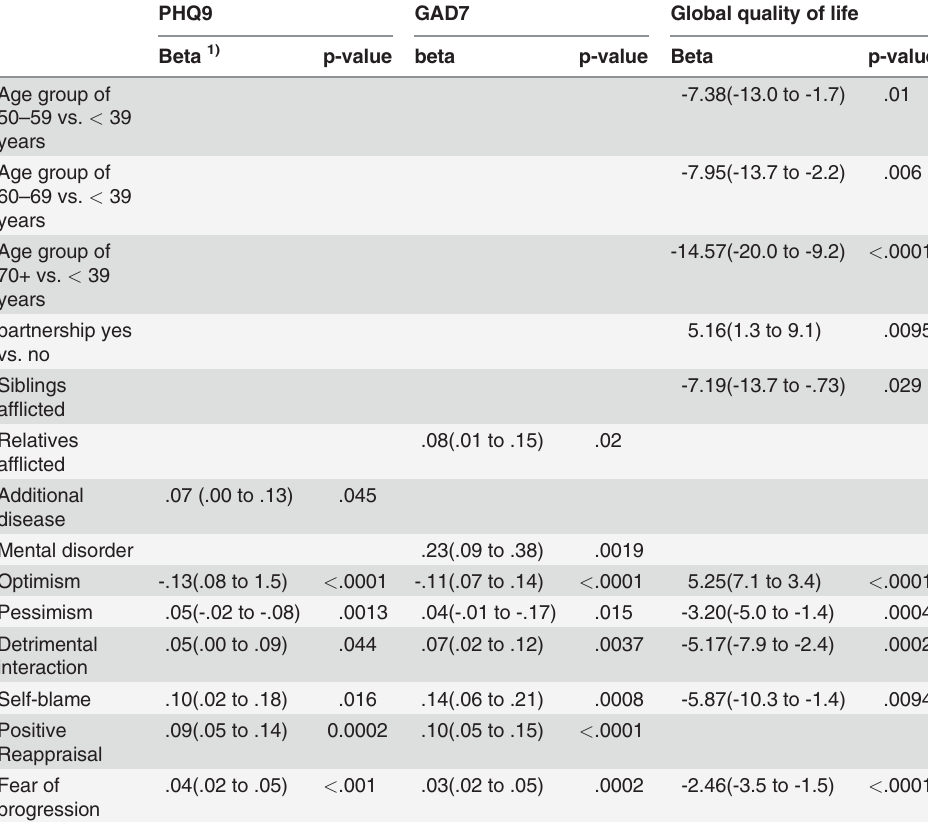
Table 4. Statistical predictors of depression (PHQ-9), anxiety (GAD-7) and global quality of life (QLQ30) in survivors of malignant